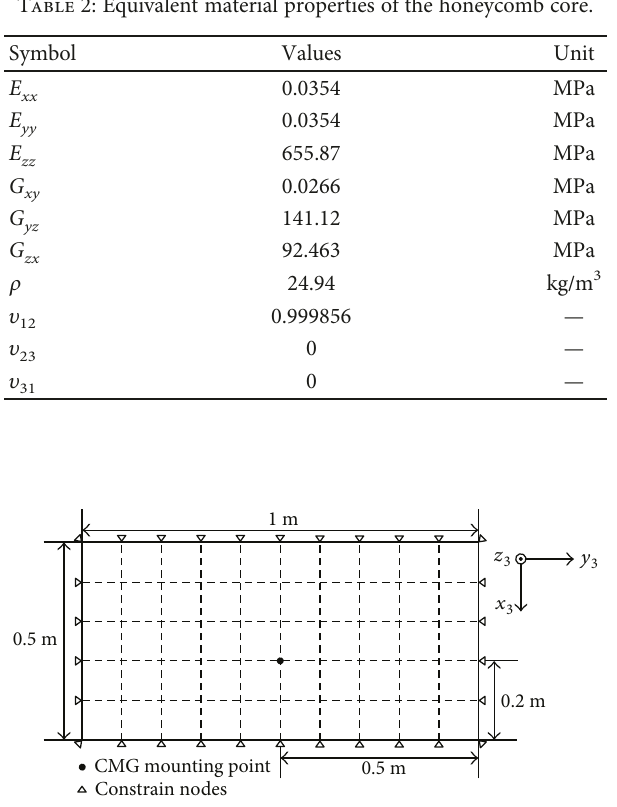
Table 2: Equivalent material properties of the honeycomb core.